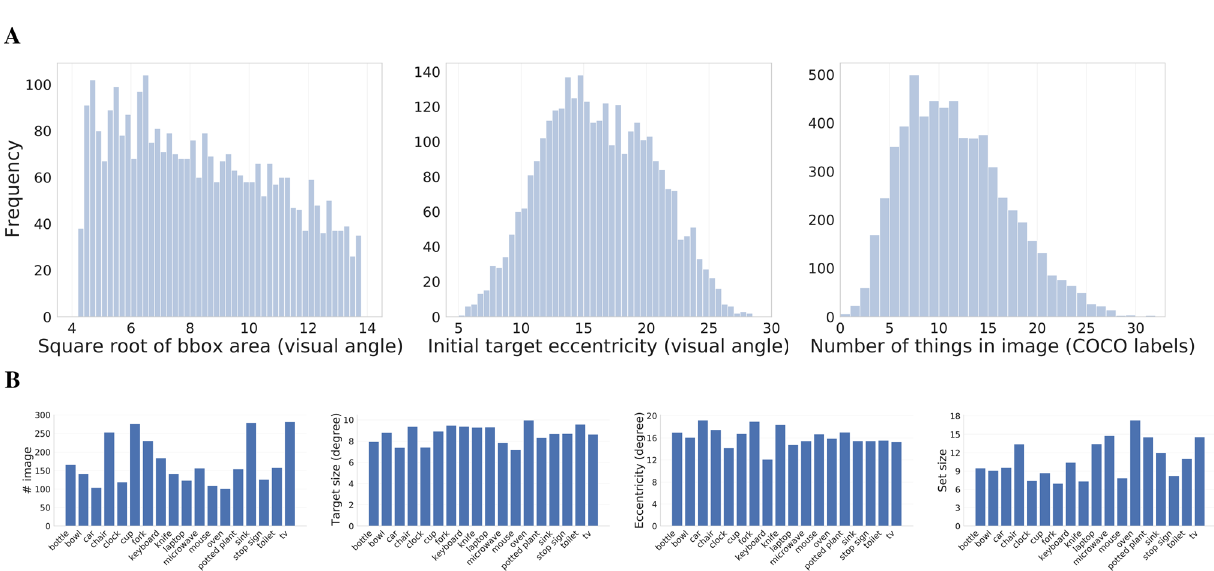
Figure 2. ( A ) Distributions of target sizes, based on the visual angle of their bounding-box areas (left), and initial target eccentricities (middle), both for the target-present images. The number of “things” (objects and “stuff” categories, both based on COCO-stuff labels) appearing in the search images (right). ( B ) Image statistics from COCO-Search18, grouped by the 18 target categories. The left plot shows the number of images, followed by three analyses paralleling those presented in ( A ): averaged target-object size in degrees of visual angle, initial target eccentricity based on bounding-box centers, and the average number of things in an image (a proxy for set